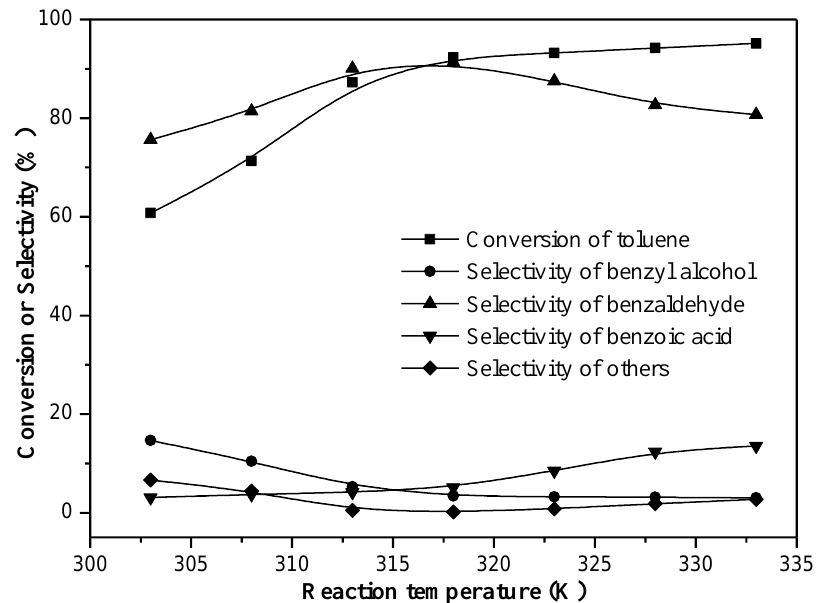
Figure 8. Effect of reaction temperature. Reaction conditions 0.20 g Co-ZIF, 0.500 mmol toluene, 20 mL HFIP, 0.004 g NHPI, 0.12 MPa O 2 and 240 min.